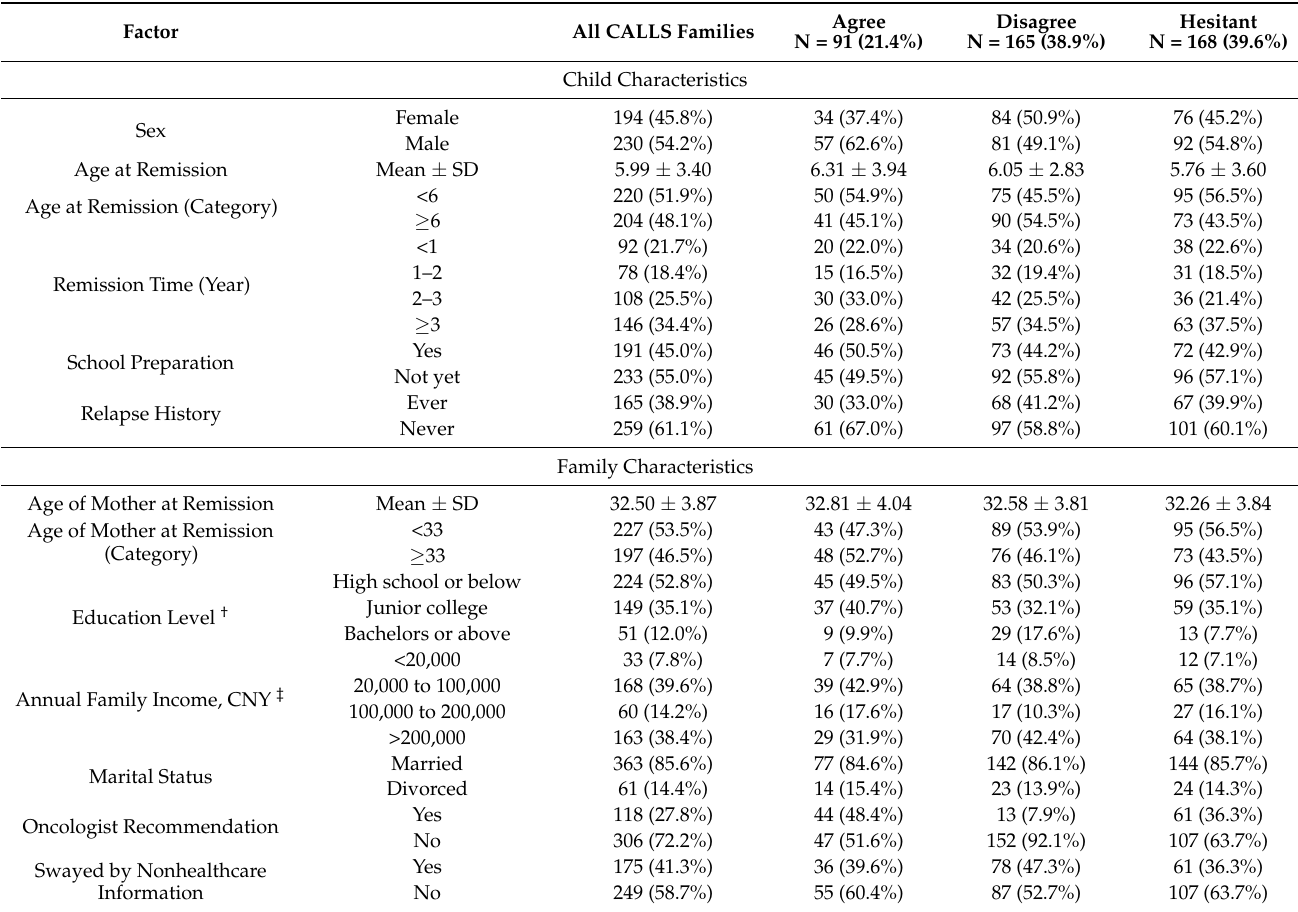
Table 1. Baseline characteristics of the included CALLS